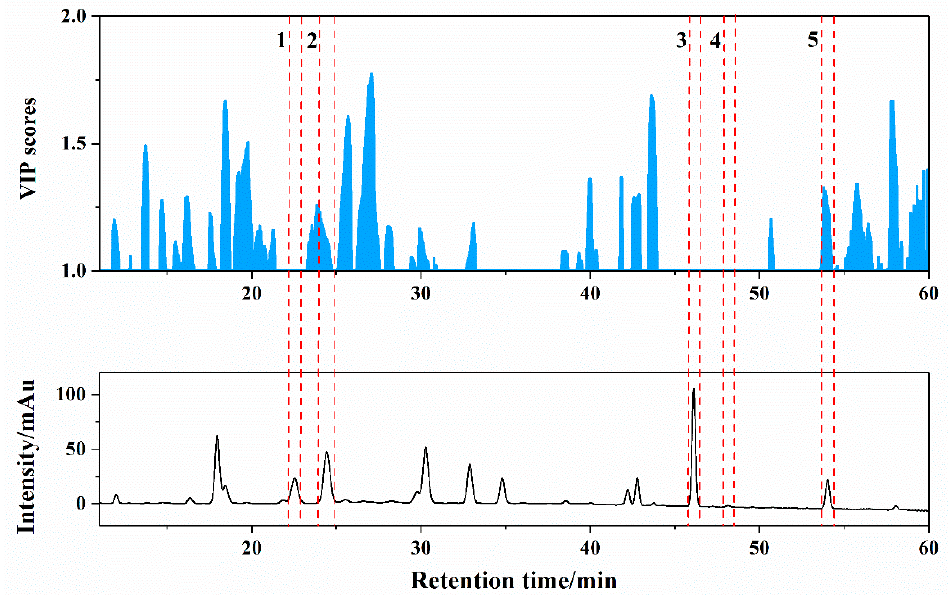
Figure 4. VIP scores of PLS-DA using LC 242 chromatogram data of Poria samples. Note: 1, dehydrotumulosic acid; 2, poricoic acid A; 3, dehydropachymic acid; 4, pachymic acid; 5, dehydrotrametenolic acid.